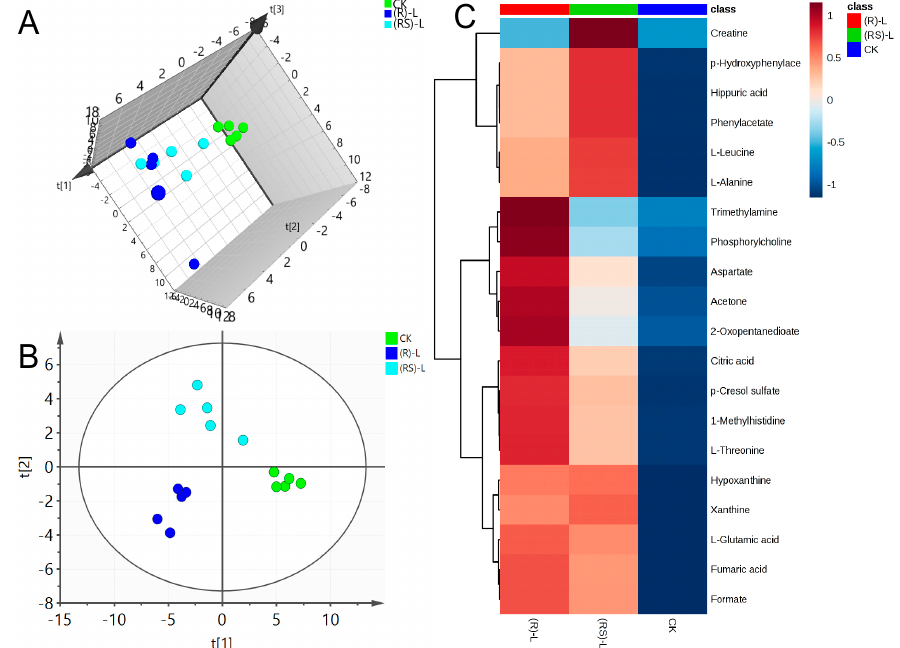
Figure 1. ( A ) Plots for the principal component analysis (PCA) score, ( B ) Plots for the partial least squares-discriminant analysis (PLS-DA) score and ( C ) heat map of earthworm metabolites after exposure to low (0.5 mg/kg) concentration of metalaxyl or metalaxyl-M. (RS)-L: 0.5 mg/kg Metalaxyl, (R)-L: 0.5 mg/kg Metalaxyl-M.